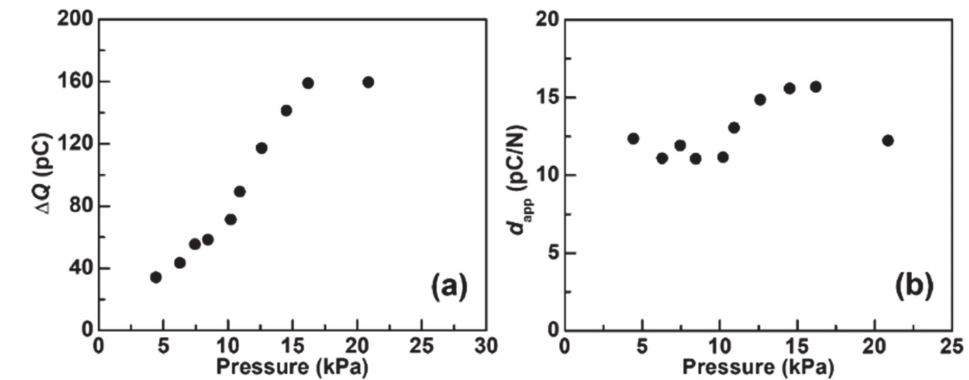
Figure 6. ( a ) ∆ Q with different applied pressures. ( b ) d app with different applied pressures.